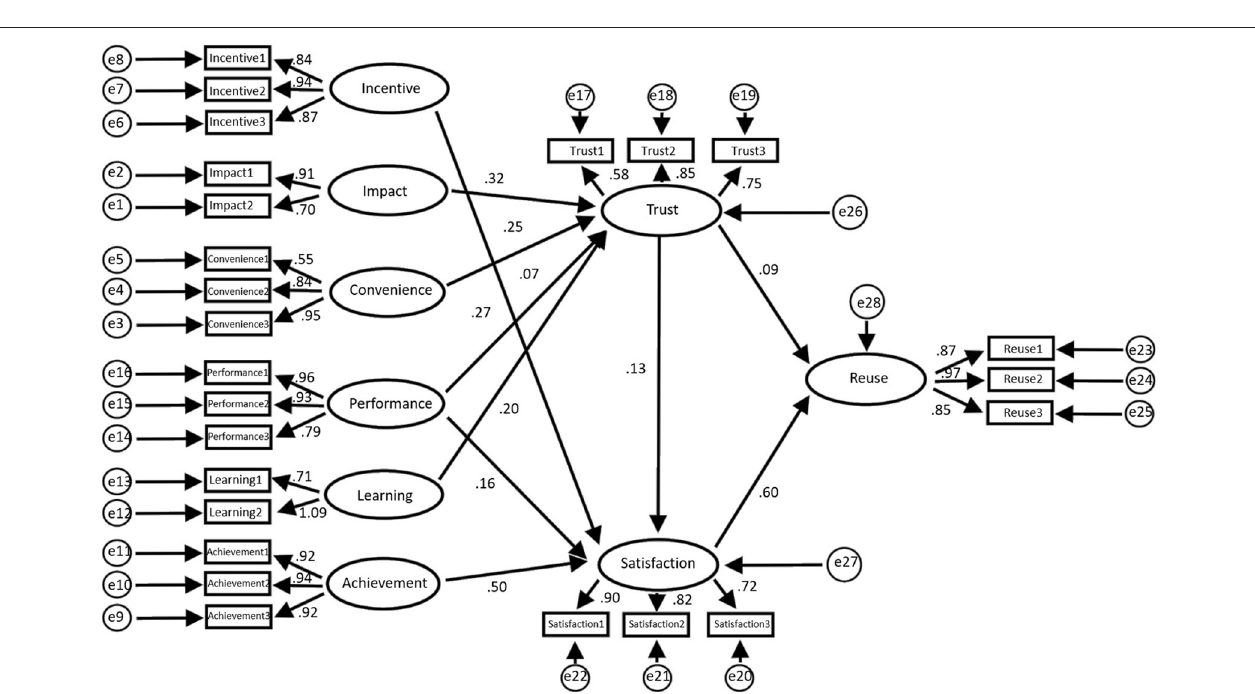
FIGURE 9 | Administrator regression weight statistics ( a : regression weight of influencing, incentive, and convenience factors; b : regression weight of learning, performance, and achievement factors; c : regression weight of trust, satisfaction, and reuse factors; d : mediation analysis conducted by enterprise administrator; A: non-standard; B: standardized C: SE value; D: T -value; E: P -value).